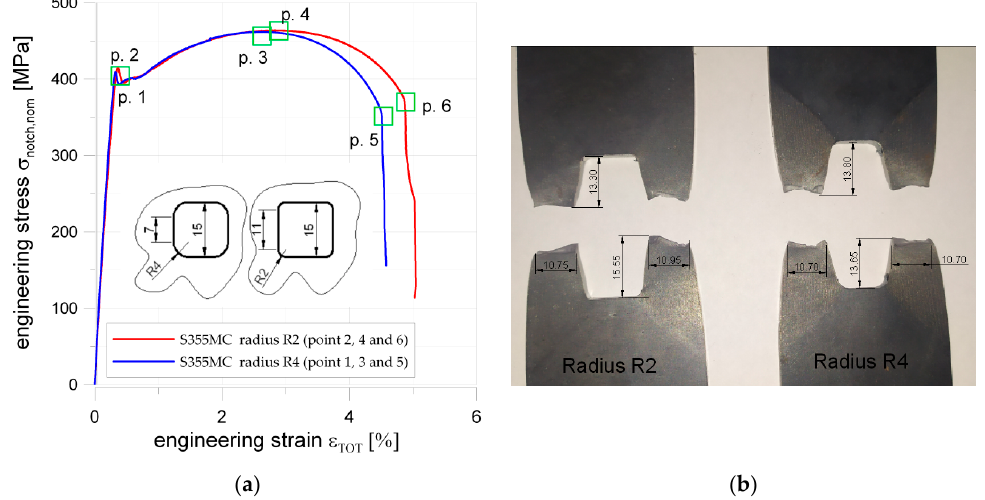
Figure 17. S355MC with rectangular hole: ( a ) engineering stress–strain curves for tested specimens and details of hole; and ( b ) failed samples made of S355MC with square hole with fillet radius R2 and